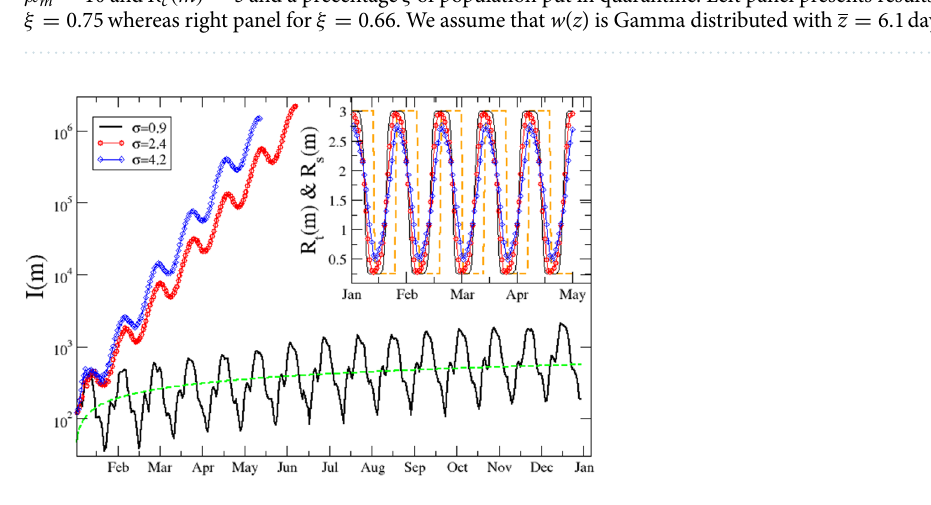
Figure 6. The simulated daily incidence I ( m ) for a periodic fast switching protocol which alternates period 1000 at the starting without constrains to rigid lockdown periods, each one lasting 12 days. We assume I ( 0 ) = time. Different colors and symbols are used for different values of σ in the probability distribution of generation time w ( z ), which is Gamma distributed. The green dashed line is a power law fit m 1 / 2 for the temporal evolution 0.95 . (Inset) We plot with dashed orange line the evolution of R t ( m ) of the average value of I ( m ) when σ = implemented in the numerical model. The other curves represent the evolution of R c ( m ) for different values of τ , with the same color code and symbols of the main